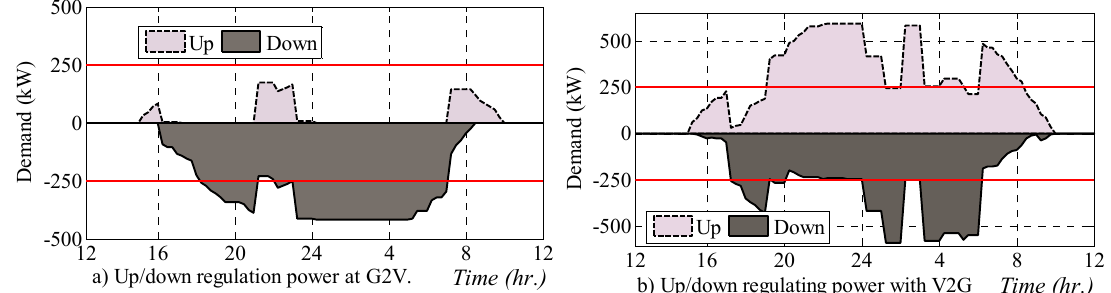
Figure 14. Up-/down-regulation capability of EVs at: ( a ) G2V; and ( b ) V2G cases.